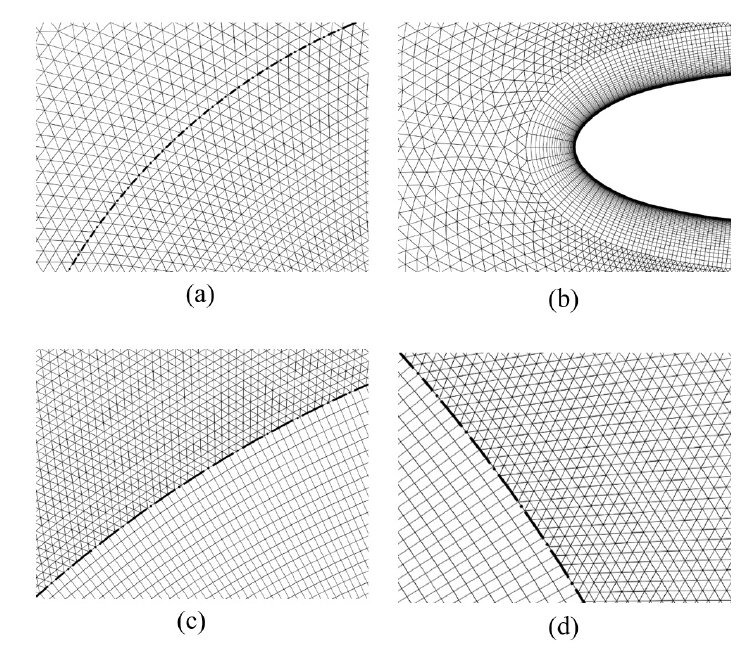
Figure 11. Details of the discretized computational domain: ( a ) interface rotor and blade region (I in Figure 9); ( b ) boundary layer (II in Figure 9); ( c ) interface rotor and fixed domain (III in Figure 9); ( d ) interface rotor and fixed domain (IV in Figure 9).